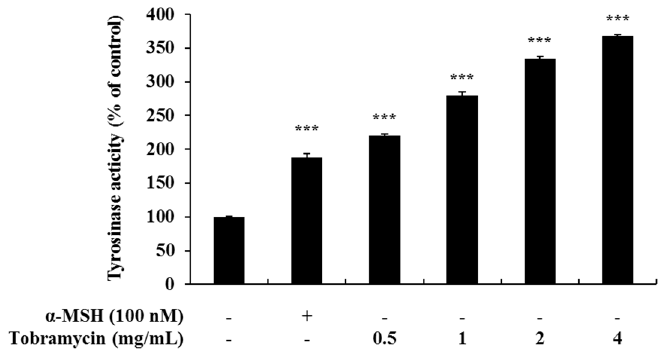
Figure 4. Tyrosinase activity in tobramycin-treated B16F10 melanoma cells. The cells were treated with various concentrations of tobramycin for 72 h, and α -MSH was used as a positive control. Data are presented as mean ± standard deviation (SD) of at least four independent experiments ( n = 4). *** indicates p < 0.001 vs. untreated cells.